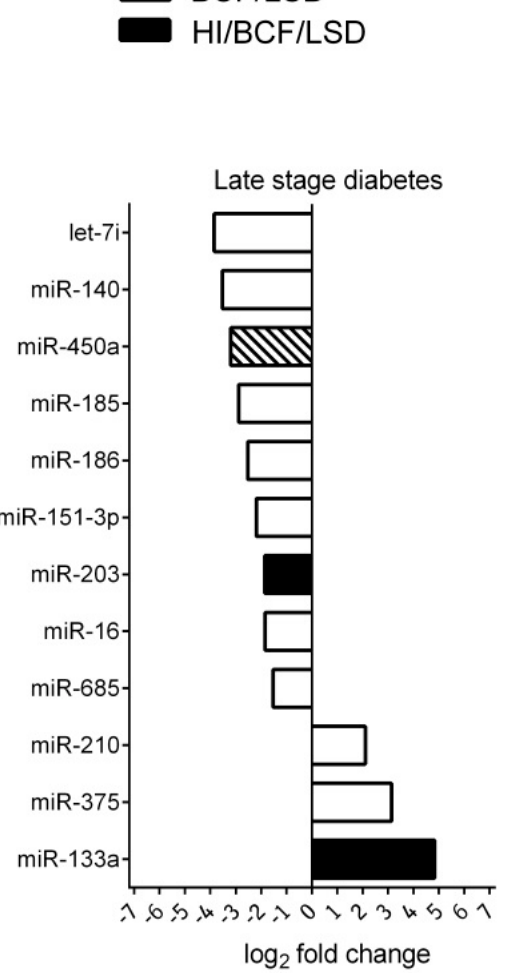
Figure 4. Significantly-altered circulating miRNAs (fold-change >2; p < 0.05) at individual time points during disease progression at hyperinsulinemia (HI), β cell failure (BCF) and late-stage diabetes (LSD) analyzed by qRT-PCR. Log 2 -fold changes of increased or decreased miRNA species at HI, BCF and LSD are indicated. Each time point was compared to the baseline (week 6 of age).